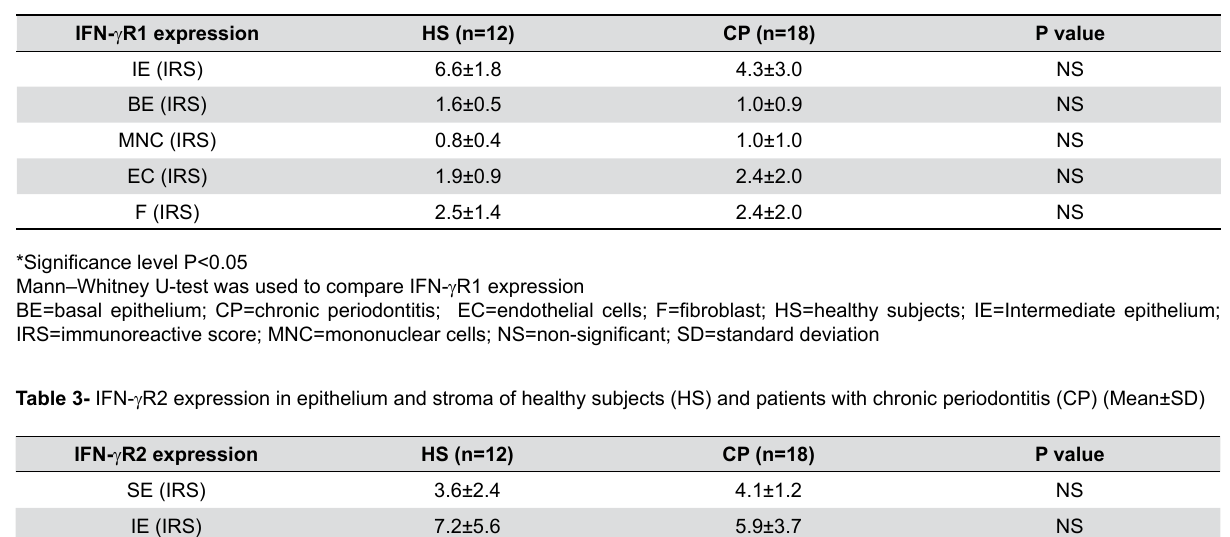
Table 2 - IFN- g R1 expression in epithelium and stroma of healthy subjects (HS) and patients with chronic periodontitis (CP) (Mean±SD)